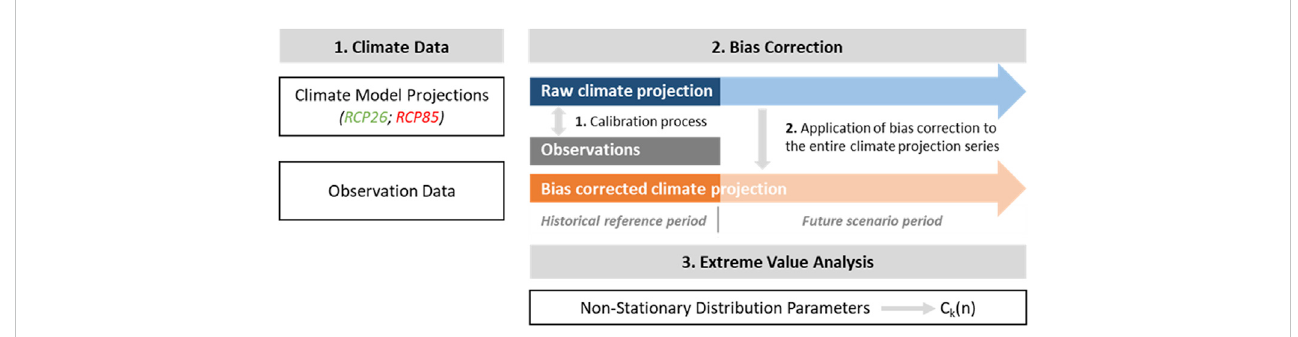
FIGURE 1 Overview of the proposed methodology for the calculation of non-stationary characteristic values of climatic actions.